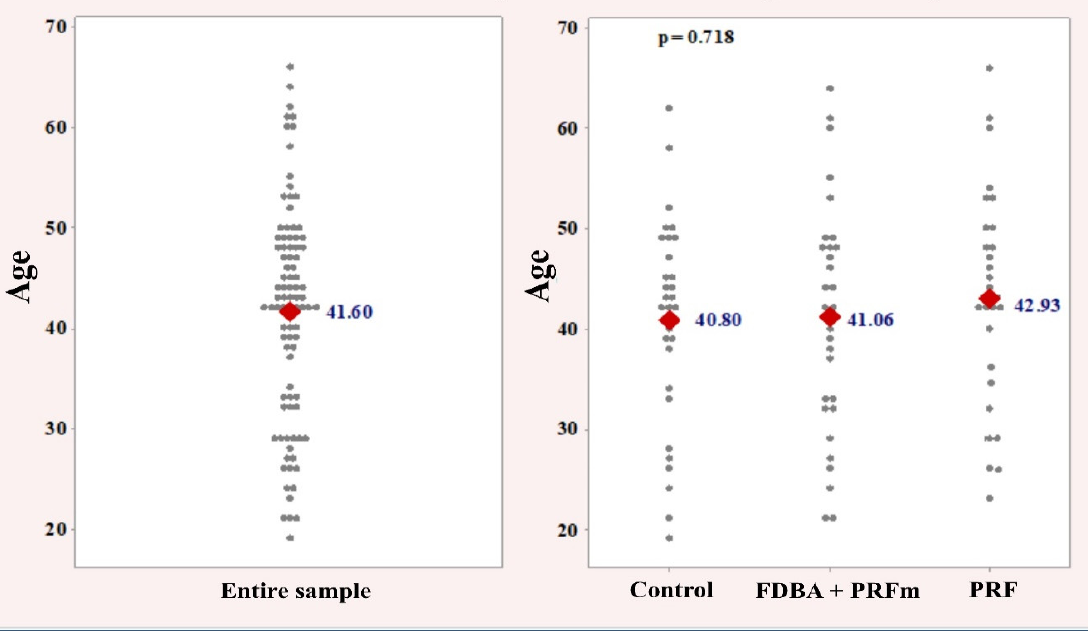
Figure 6 . Distribution of the patients according to their age for the entire sample ( left ), and groupwise ( right ). The relative share of men and women within the sample is equal, with 45 men (50%) and 45 women (50%). A similar distribution by gender, with no significant difference was found in the study groups ( p = 0.875): bone: 53% female, 47% male; PRF: 50% female, 50% male; control group: 47% female, 53% male.